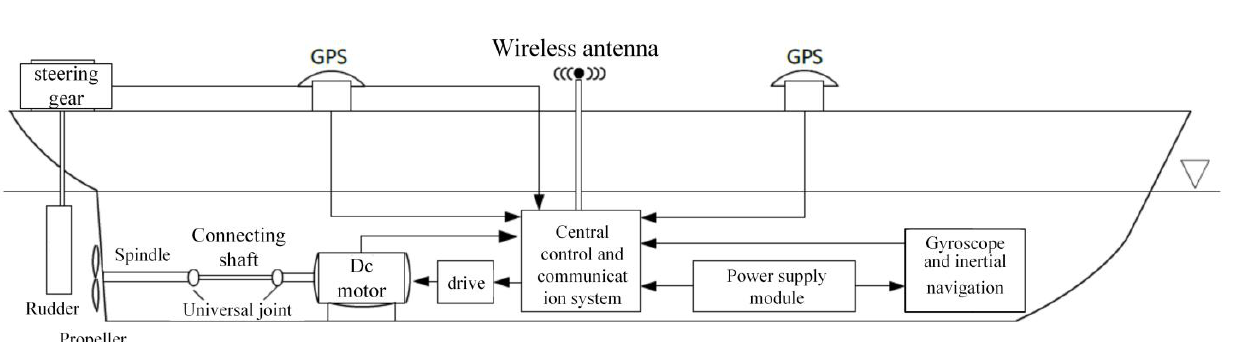
Figure 4. Schematic diagram of the free self-propelled model test platform system.